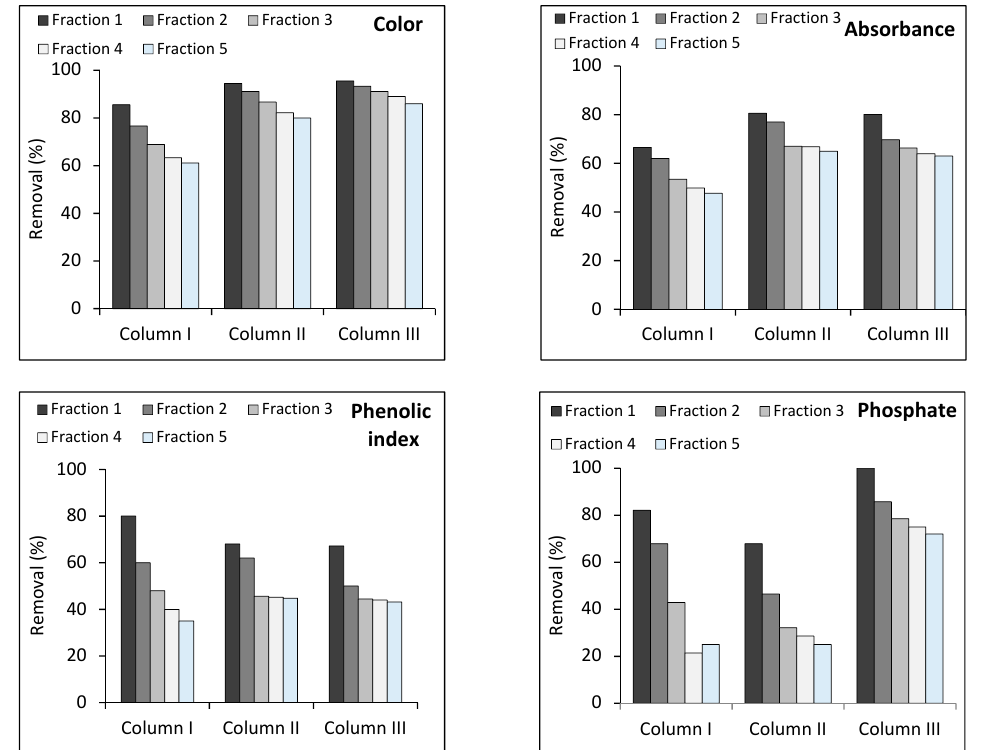
Figure 6. Effluent treatment in fixed bed column in time.